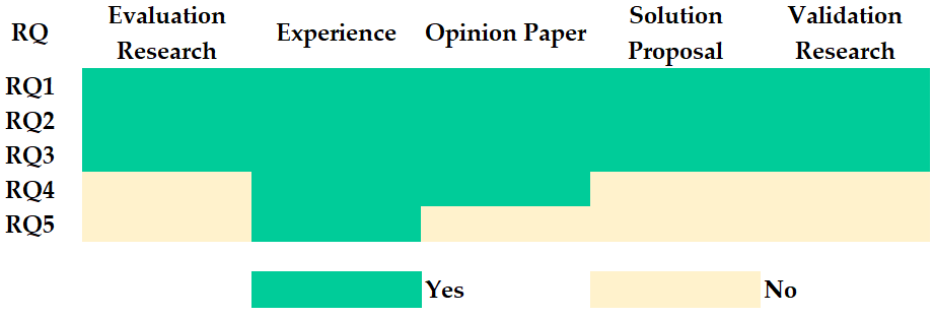
Figure 7. Contribution of research questions to the study.